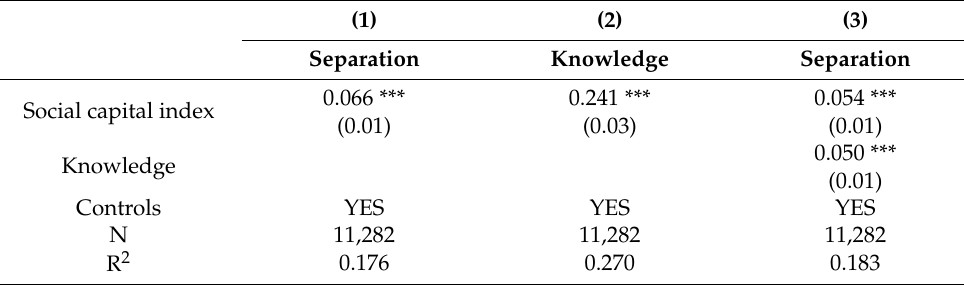
Table 7. Mediating effect of social learning: environmental knowledge score.